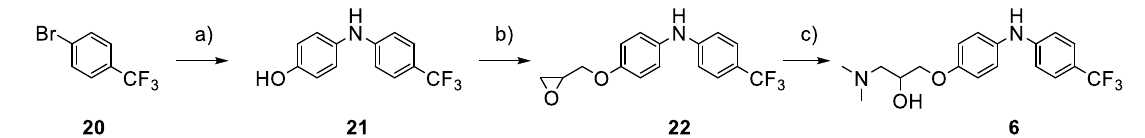
Figure 4. Reagents, solvents, and conditions: ( a ) 4-aminophenol, BrettPhos, Pd(dba 3 ) 2 , NaO t -Bu, 90 °C, 12 h; ( b ) (±)-epichlo- rohydrin, MeCN, K 2 CO 3 , 80 °C, 16 h; ( c ) Me 2 NH × HCl, MeOH, 70 °C, 24 h.